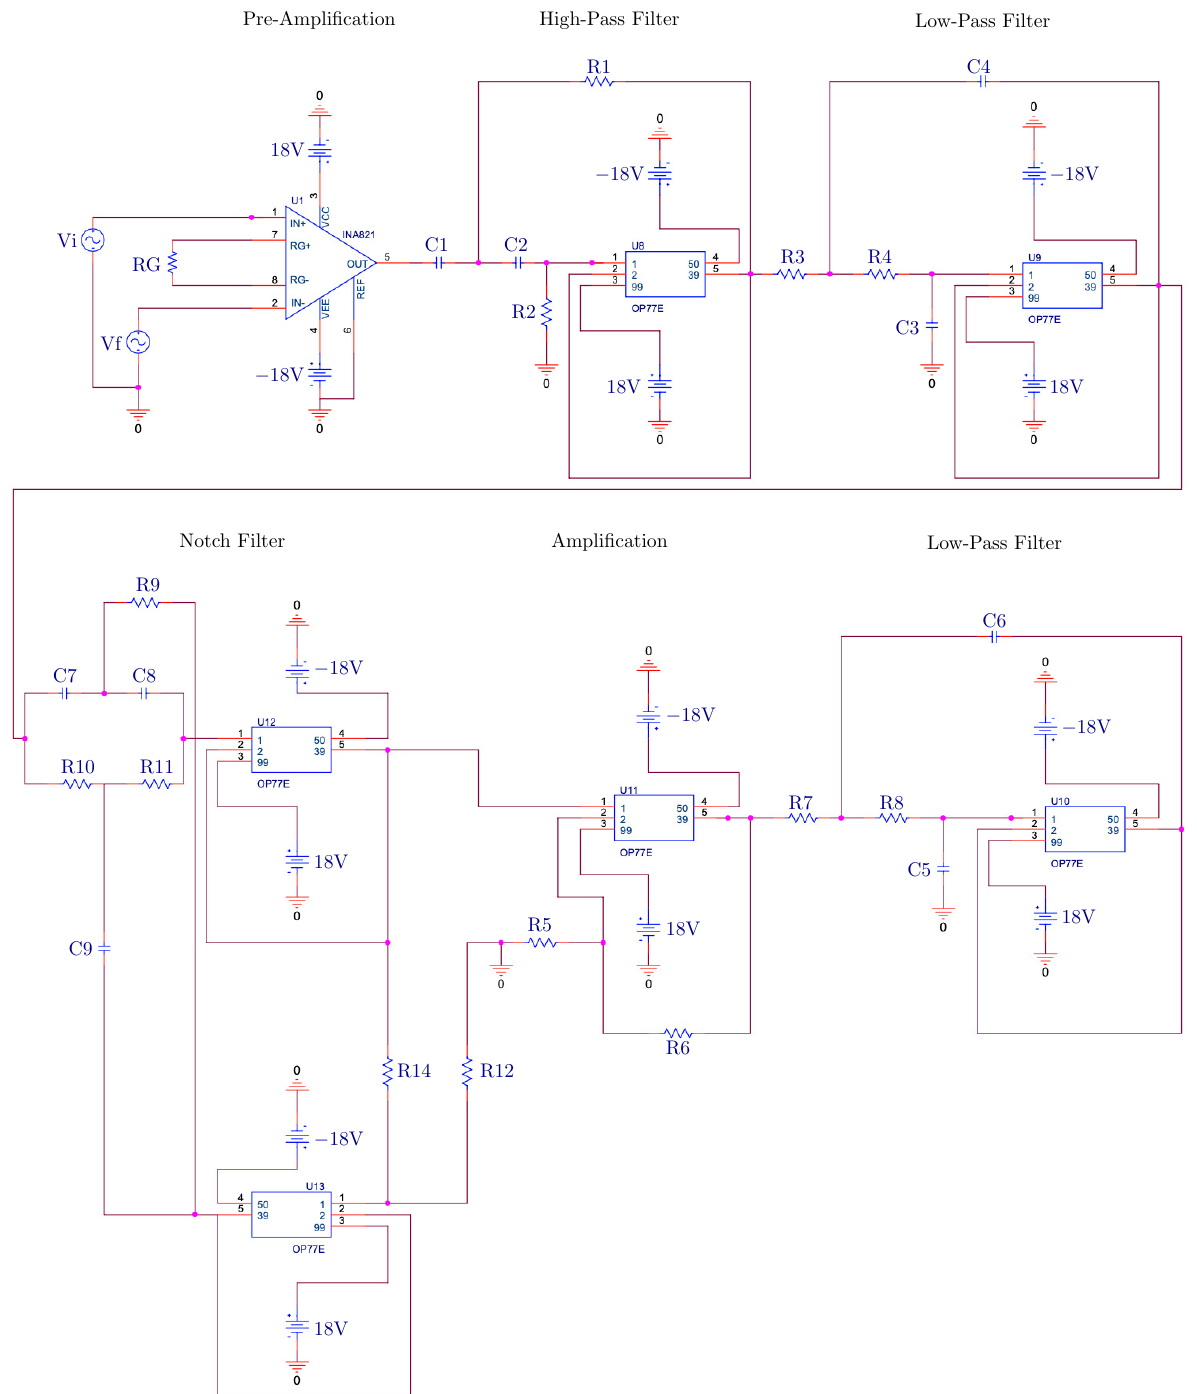
Figure 5. Schematic diagram of the second developed signal conditioning circuit. In the pre- amplification stage, an INA821 instrumentation amplifier is employed. In the high-pass, low-pass, and notch filters steps, and in the amplification stage, an OP77 op-amp is employed as